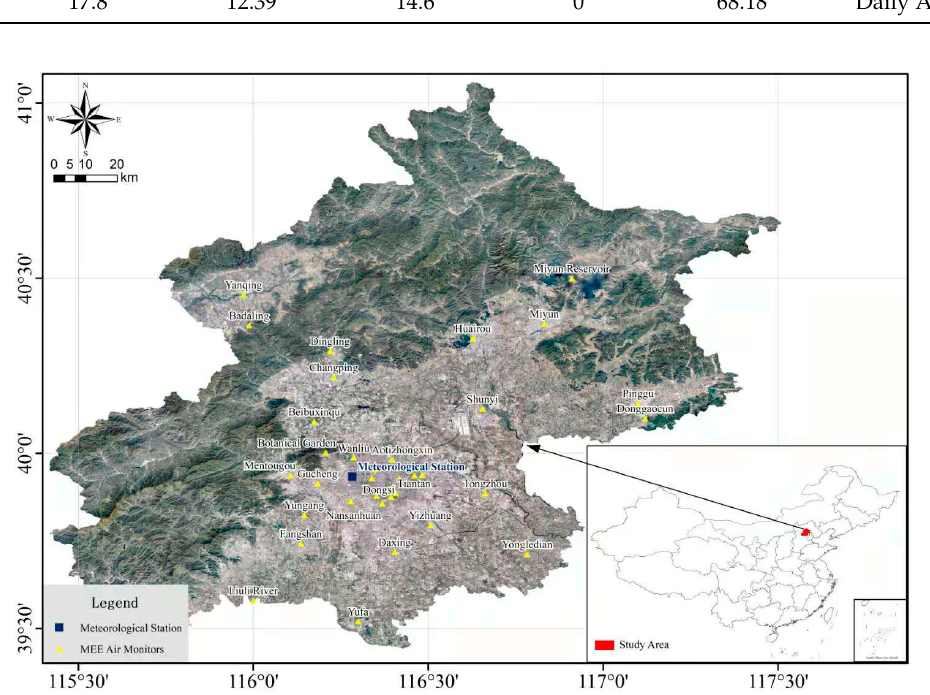
Figure 1. Distribution map of monitoring sites. Table 1. Detailed characteristics of the data used in the model.